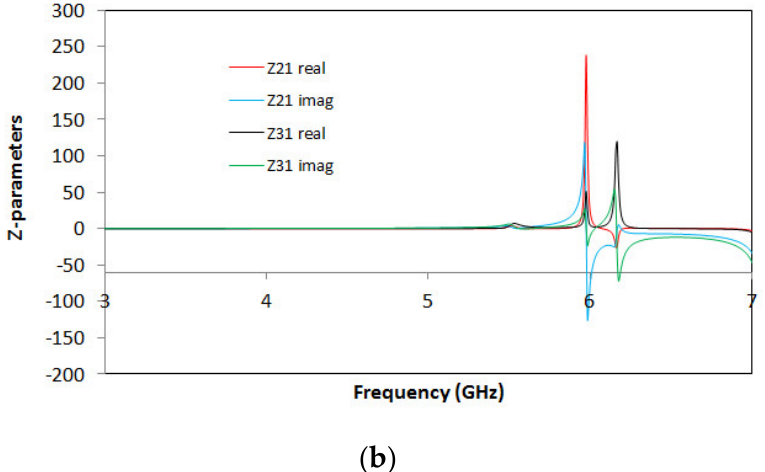
Figure 24. ( a ) Simulated S21 (solid black line), simulated S21 for the equivalent circuit model (dashed black line), simulated S31 (solid blue line), simulated S31 for the equivalent circuit model (dashed blue line). ( b ) Impedance graph: Z21 real part (solid red line), Z21 imaginary part (solid blue line), Z31 real part (solid black line), Z31 imaginary part (solid green line).